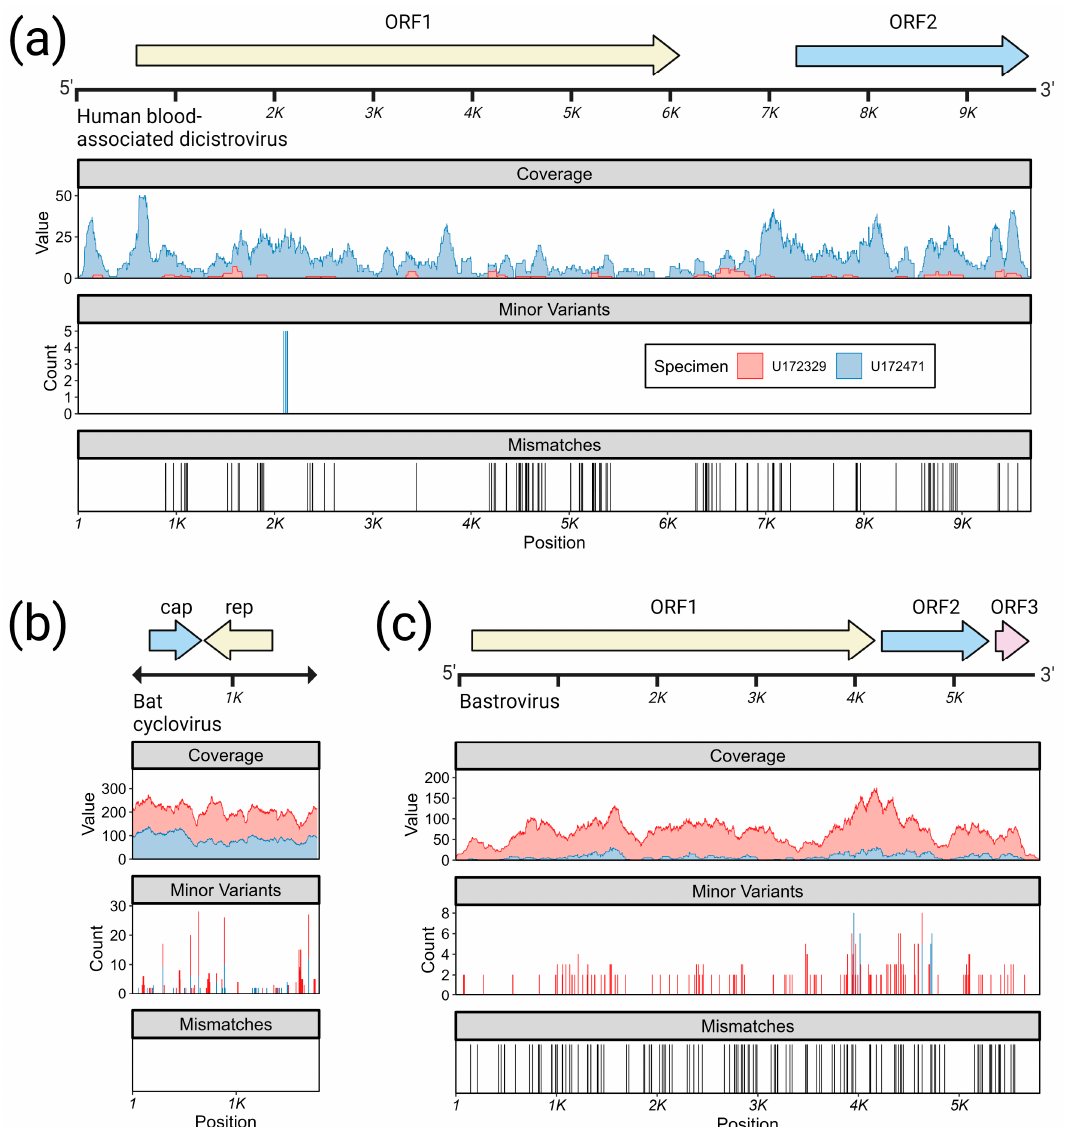
Figure 3. Genomic maps and mapping statistics for three viruses found in specimens U172329 and U172471 that have previously been detected in mammals: ( a ) human blood-associated dicistrovirus, ( b ) bat cyclovirus, and ( c ) bastrovirus. In each panel, mismatches represent single-nucleotide polymorphisms detected between the U172329 and U172471 isolates (Figure created using assets from BioRender.com).